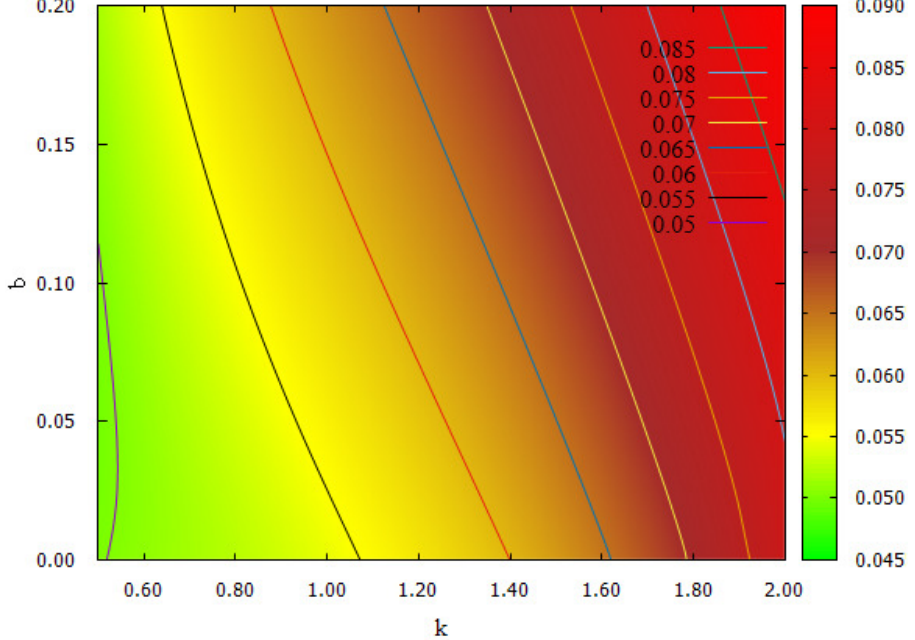
Figure 1. Pyragas’ factor variation rate in comparison to damping factor b and to forcing amplitude k